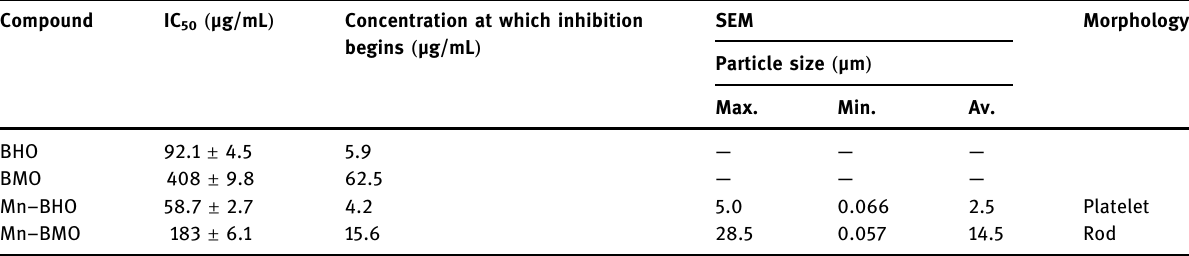
Table 3: SEM results and inhibition of M - NFS - 60 cell line by ligands and their Mn ( II ) complexes